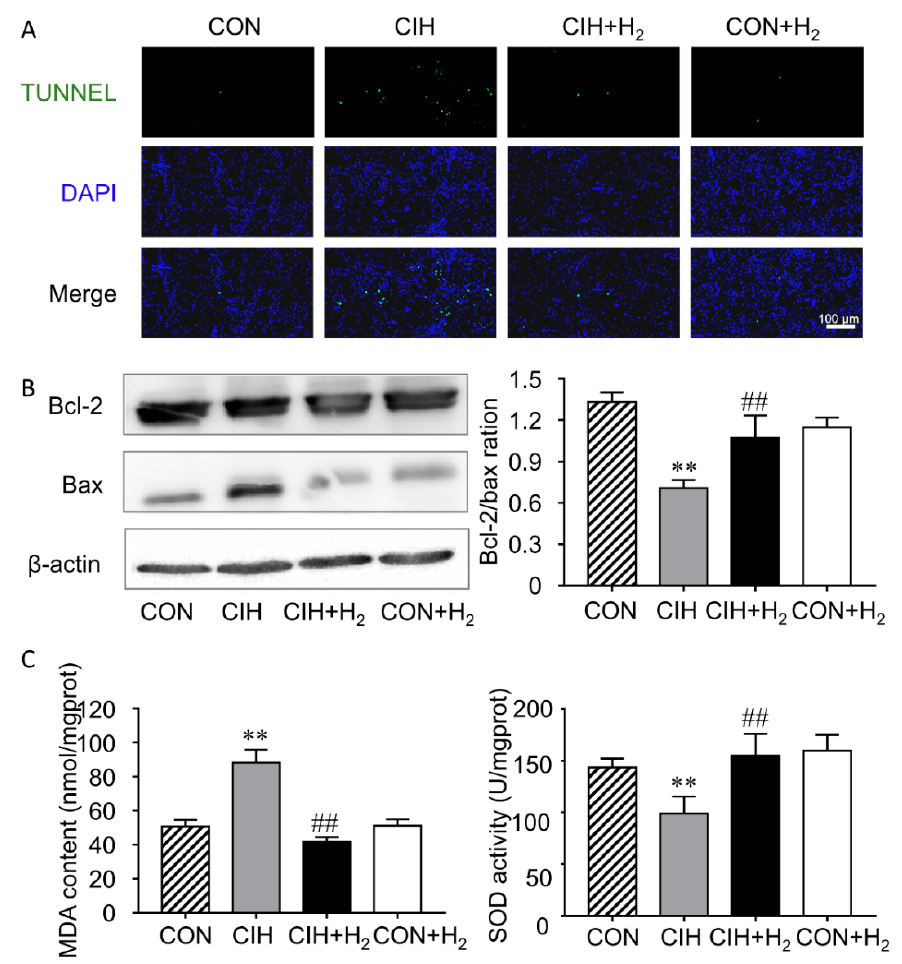
Figure 2. Effect of H 2 on CIH-induced renal cell apoptosis and oxidative stress. ( A ). Representative images of cell apoptosis. ( B ). Western blot showing that H 2 inhibited the decrease of Bcl-2/bax ratio. ( C ). H 2 administration suppressed renal MDA (malondialdehyde) content and increased SOD (superoxide dismutase) activity. ** p < 0.01 vs. normoxia group; ## p < 0.01 vs. CIH were determined. The data showed that, the renal MDA level was significantly increased after suffering from CIH, whereas that of SOD activity decreased significantly. H 2 decreased MDA levels and elevated the activity of SOD. (Figure 2C).